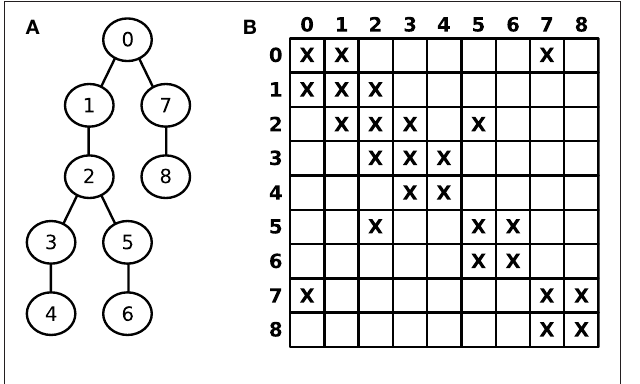
FIGURE 3 | (A) Numbered graph representing a set of connected compartments. (B) Layout of the corresponding matrix G .